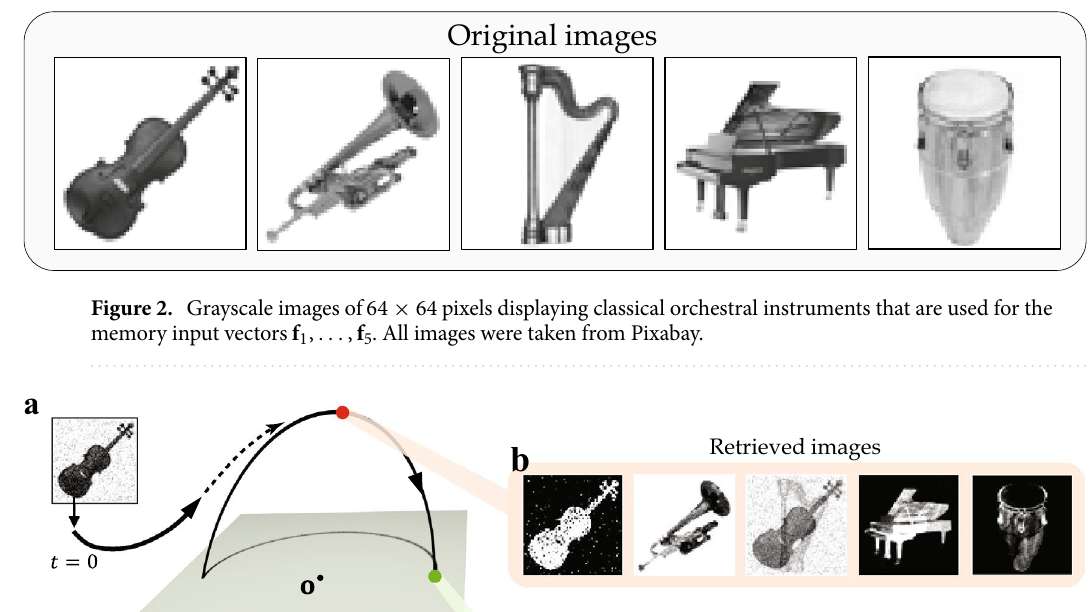
retrieved images at the farthest point (red dot) from memory plane S . ( c ) Snapshot of the retrieved images at the intersection (green dot) of the orbit and the memory plane S . The timing of intersection t = t † > 0 can be analytically determined as t † = ( tan − 1 ω + n π)/ω , n ∈ Z 2 . Here, the contrast between the main object and the background are not well reproduced as the original images, since the brightness threshold σ = 0.005 is used for drawing the retrieved images. One can obtain an original(either identical or exactly inverted) image by using a certain optimal value of σ for each retrieved